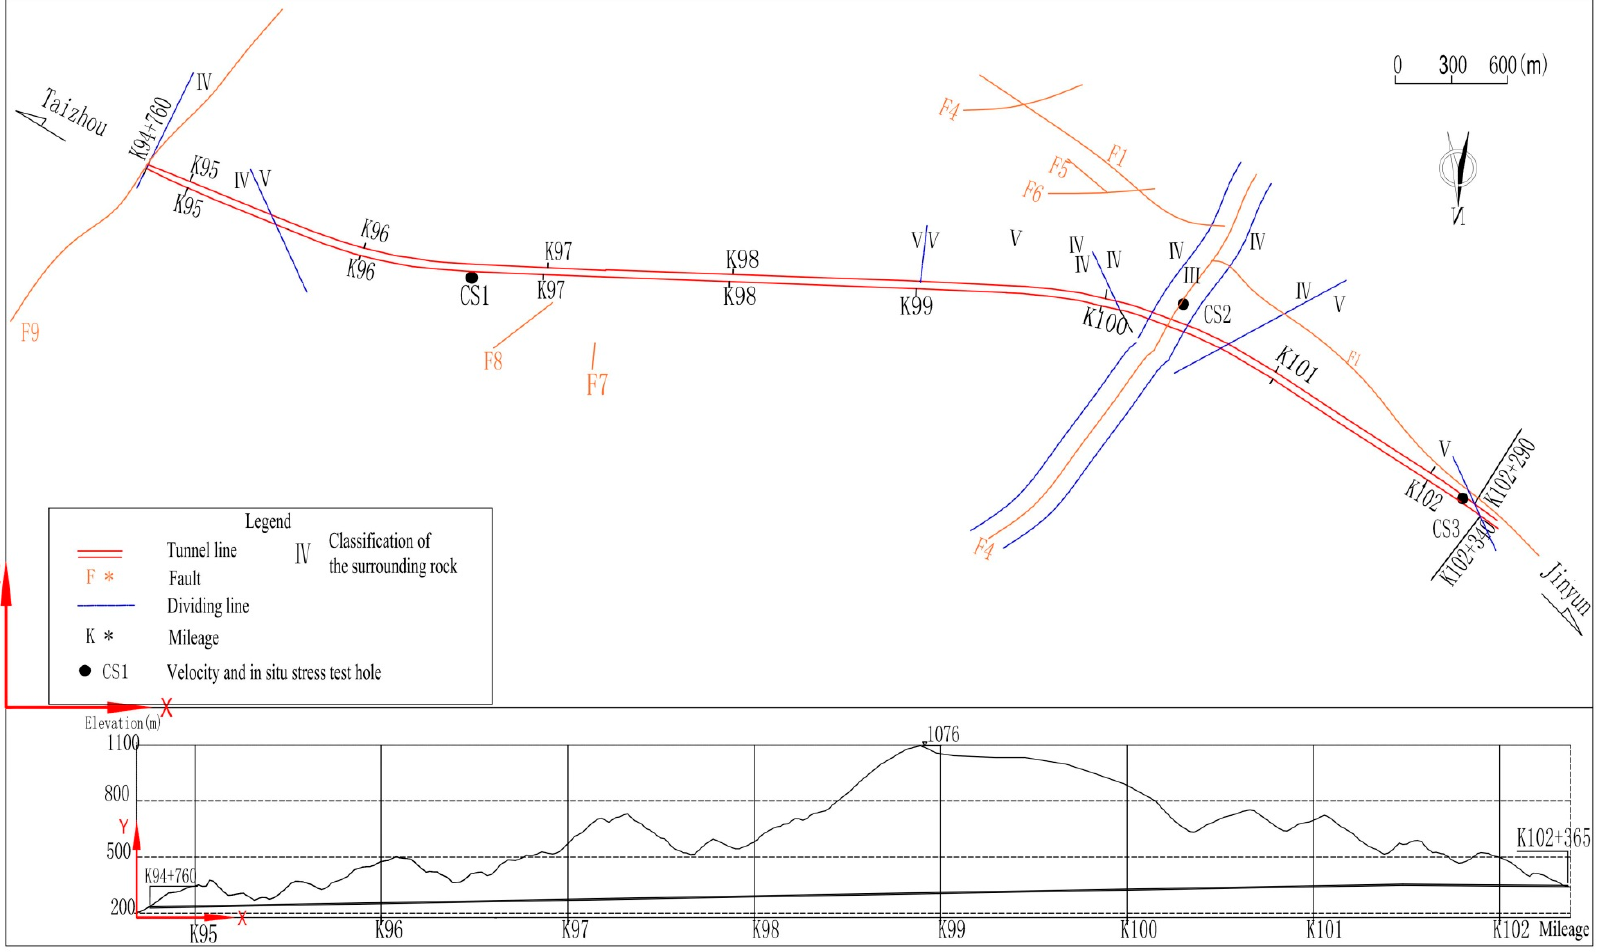
Figure 3. Plane and vertical sectional diagram of Cang Ling Tunnel.